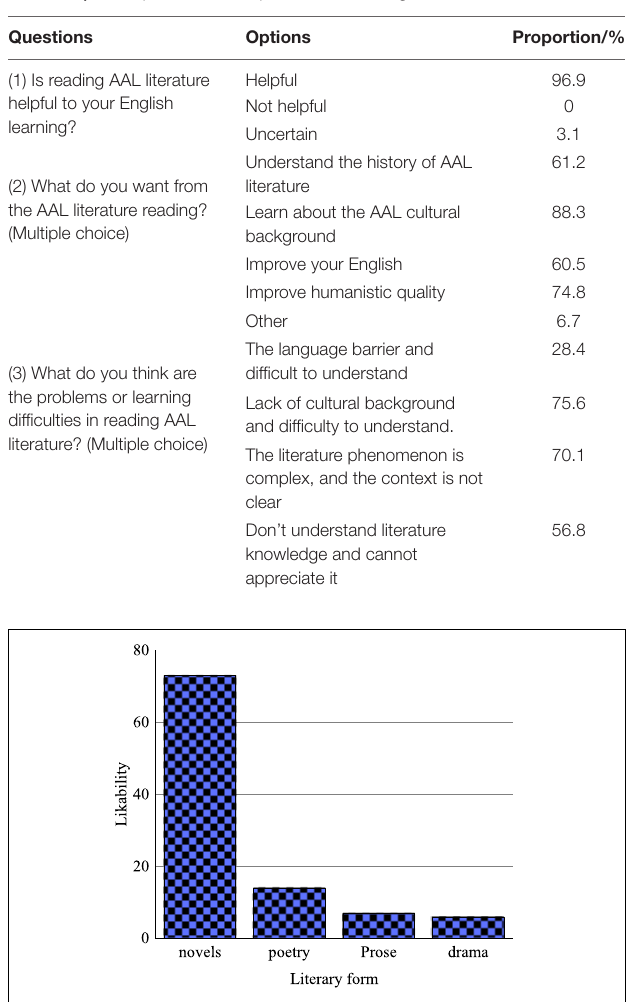
TABLE 6 | The expectations and problems in reading AAL literature.